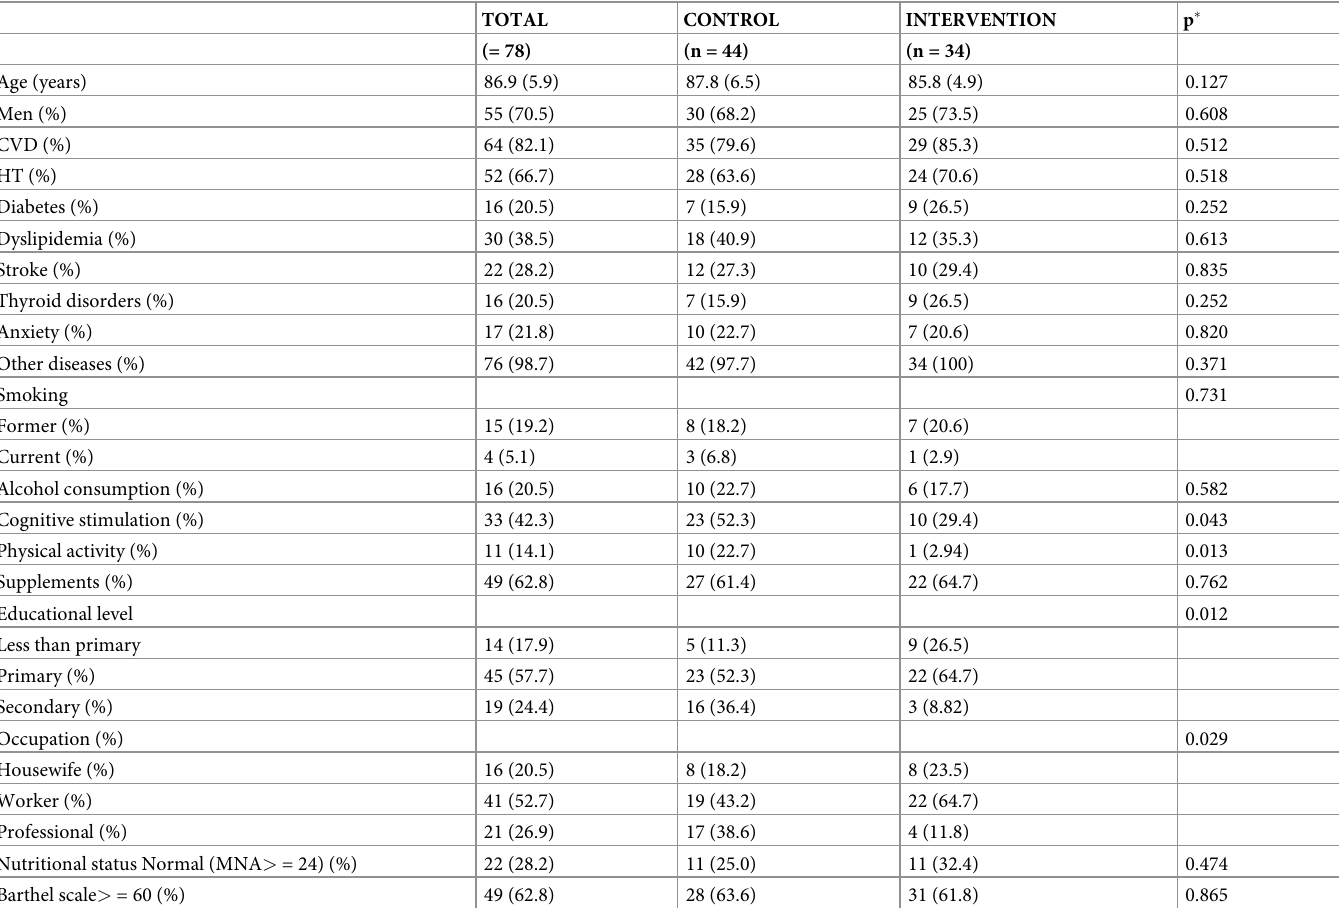
Table 1. Baseline characteristics of participants according to the study